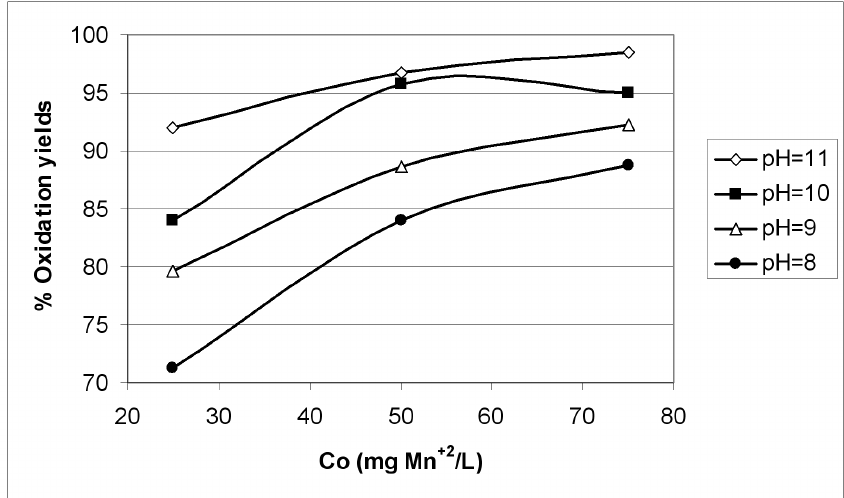
Fig. 3 Oxidation yields as a function of pH and concentration (20 ◦ C, solution with glass beads and 0.2 g MnO 2